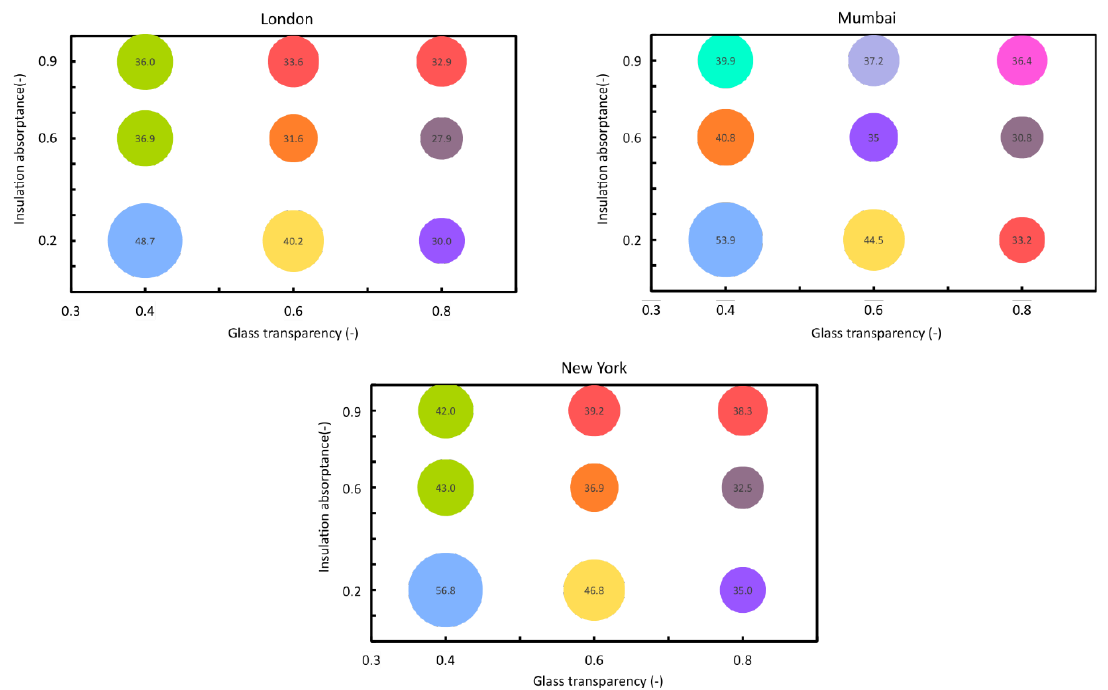
Figure 10. Least square mean (radius of circles) of temperature gradients for the three analyzed locations. Per each location, a combination of variables that leads to results sharing the same circle color means that the combination is not statistically different.